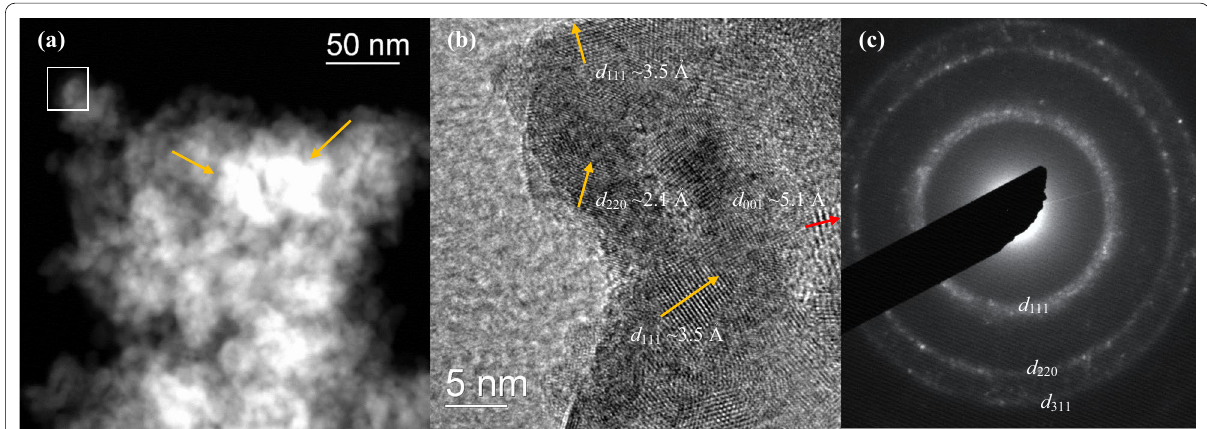
Fig. 4 High‑angle annular dark‑field scanning transmission electron microscopy (HAADF‑TEM) image ( a ), high resolution‑transmission electron microscopy (HR‑TEM) image ( b ), and selected area electron diffraction (SAED) pattern ( c ). The sample was obtained from 0.015 M Cd(II)‑added 2 g/L FeS batch at pH 4.6. Part b is an enlarged image of the boxed area in part a . In part b , orange arrows indicate the lattice fringe patterns of hawleyite, and the yellow arrow indicates those of mackinawite. In part c , the reflection rings are indexed for hawleyite